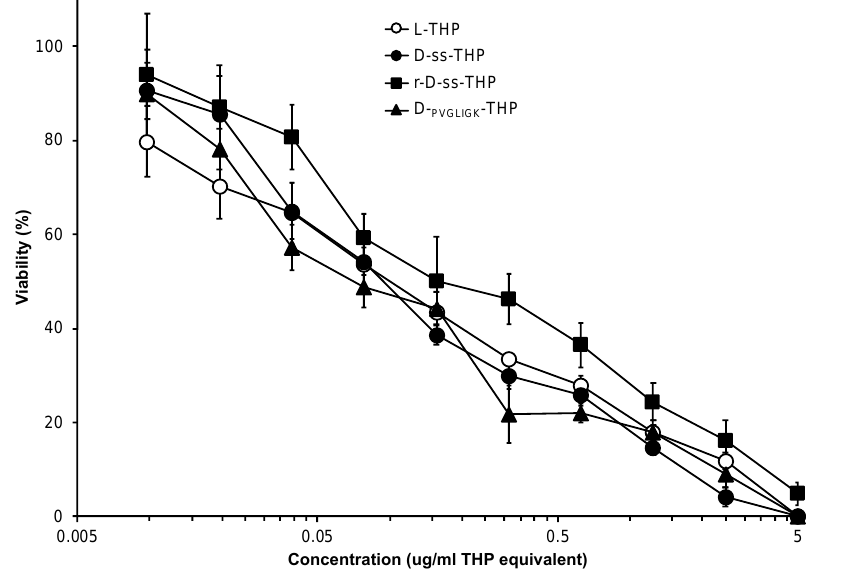
Figure 5. In vitro cytotoxicity of free L-THP and diblock P-THPs against C26 cells. Cells were treated with each THP derivative for 72 h, and then an MTT assay was carried out to quantify viable cells. Values are means ± S.D. ( n = 7 – 8).